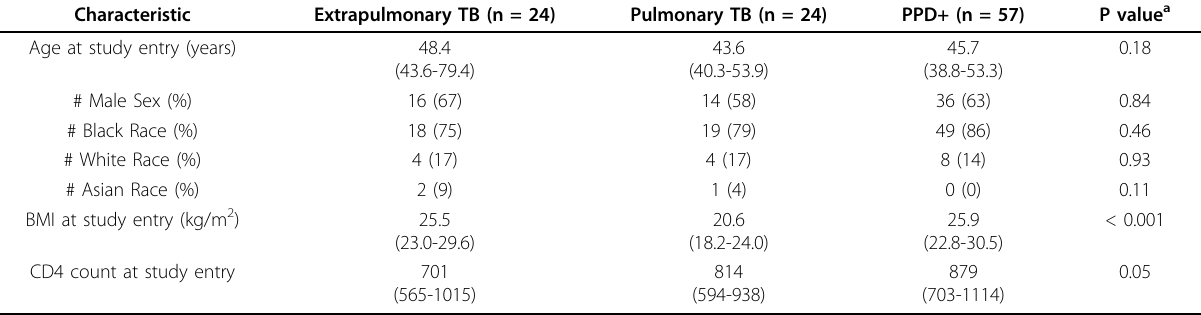
Table 1 Clinical and Demographic Characteristics of the Study Population